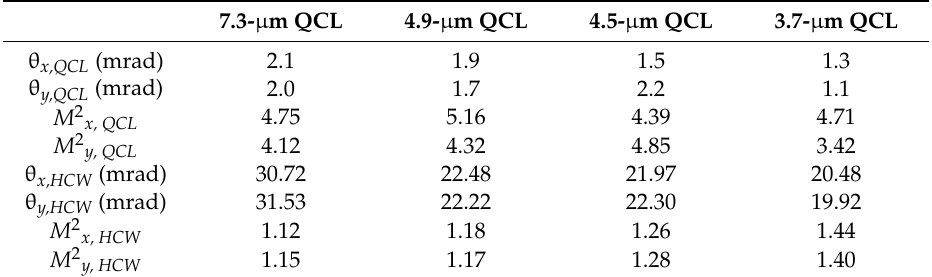
Table 2. Divergence angles and M 2 values for four QCLs and the 15-cm-long HCW, in two directions ( x and y ) orthogonal to the QCL beam propagating z